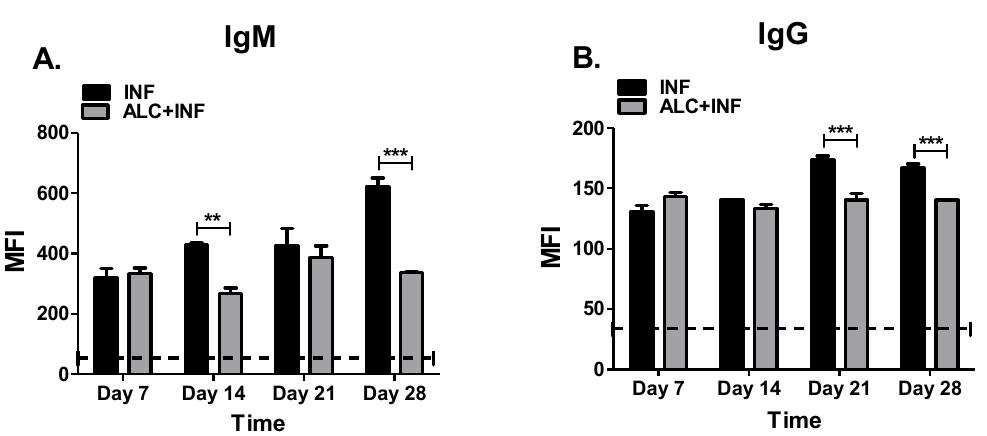
Figure 6. Specific IgM and IgG for capsular polysaccharide (CPS). The mice were treated as described in Figure 3. Whole blood was collected weekly until 28 days PI. B. pseudomallei CPS antigen (5 µ g / mL) was coupled to MagPix microspheres and reacted with a 1:1000 serum dilution from infected mice (INF) or mice infected and exposed to alcohol (ALC + INF). Specific CPS IgM ( A ) and IgG ( B ) were measured from serum samples. Bars represent mean fluorescence intensity (MFI) per treatment with SEM. Dashed lines represent base values of control groups (CON or ALC). Horizontal line represents statistical comparison between INF and ALC + INF among weekly blood collections determined by Student’s t -test, n = 3. ** p ≤ 0.01 and *** p ≤ 0.001.